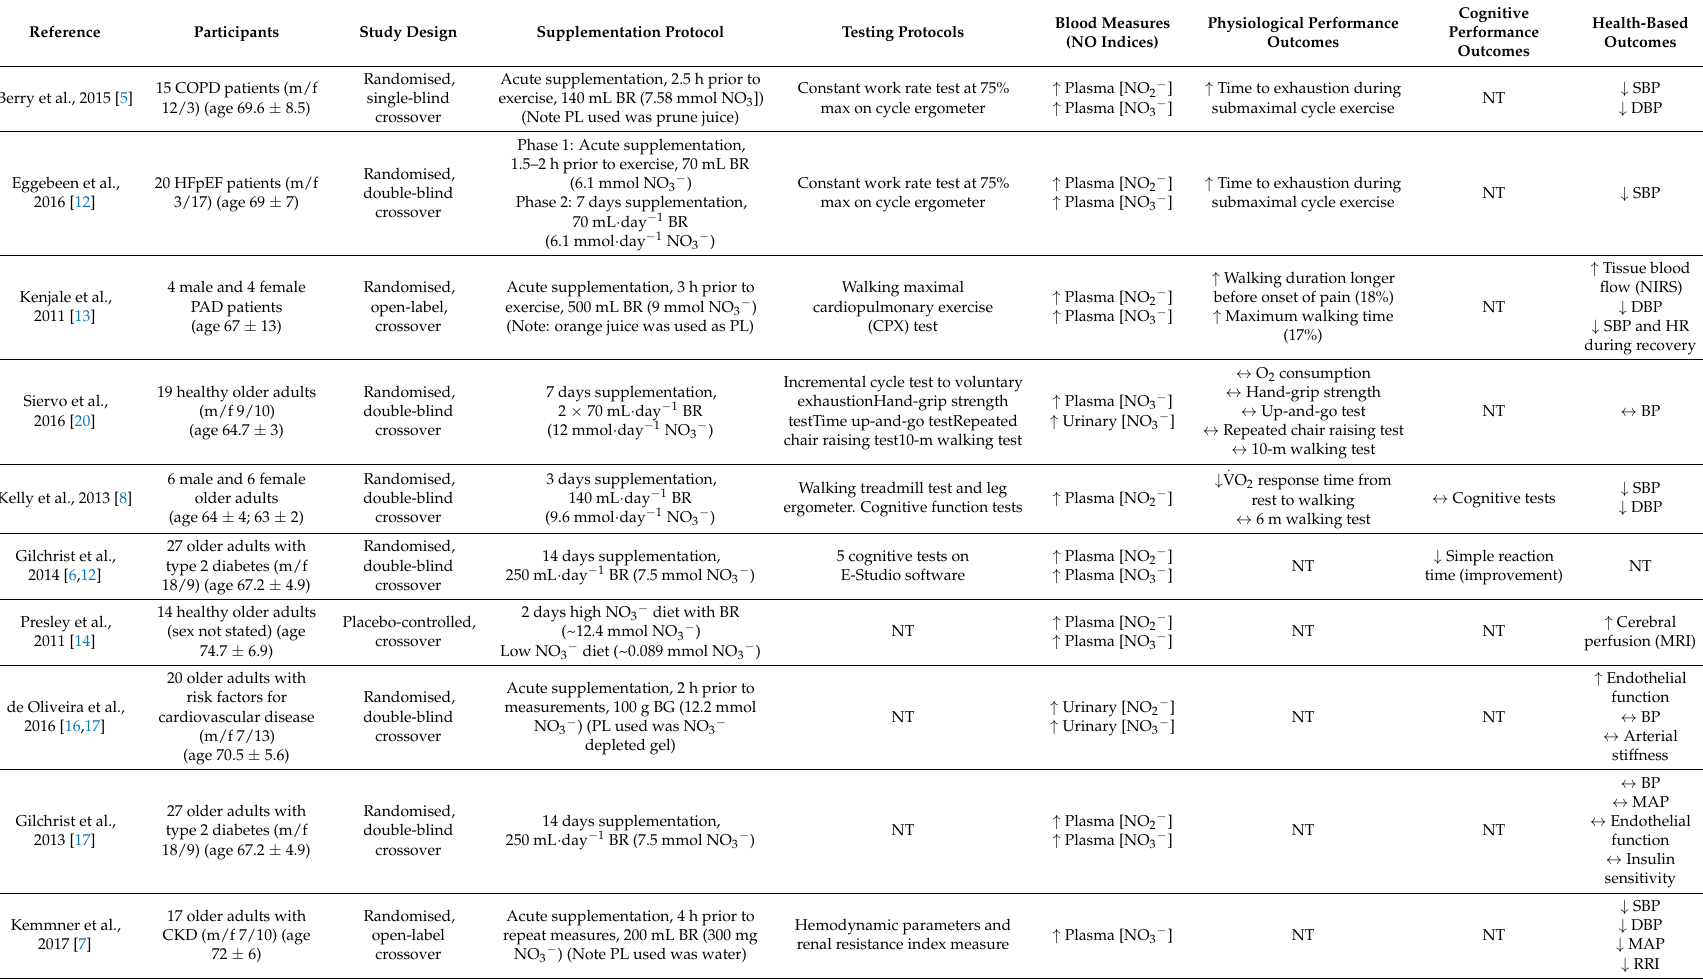
Table 1. Summary of studies investigating the effects of dietary nitrate supplementation on physical performance, cognitive performance, and health-based outcomes in older